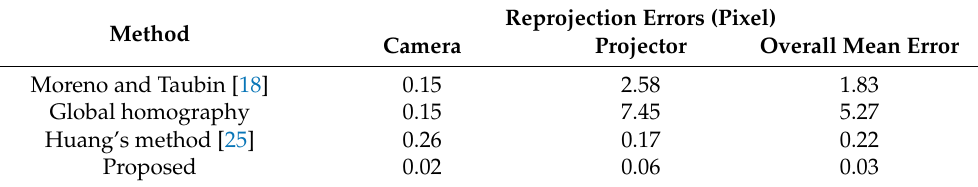
Figure 8. Calibration results of an FPP system using the proposed method. ( a ) The intrinsic and structural parameters of the FPP system and ( b ) the diagram of stereo model of the FPP system. Table 2. Calibration reprojection errors (pixels) with different methods.